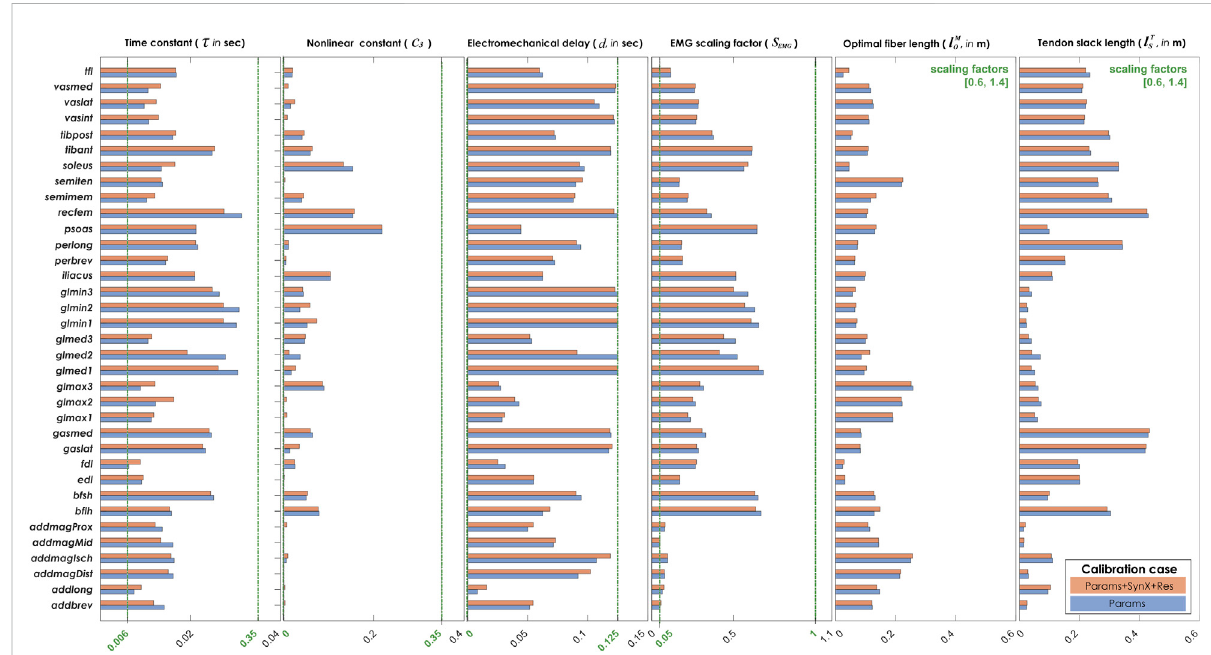
FIGURE 7 Average EMG-driven model parameters of both subjects from “ Params ” calibration (in blue) and “ Params + SynX + Res ” calibration (in orange) Results for “ Params + SynX + Res ” calibration were produced using the best performing methodological combinations for analyzing experimentally measured walking motions (trial-speci fi c unmeasured and speed-speci fi c residual synergy vector weights with six synergies). The upper and lower bounds for each of the four activation dynamics model parameters during optimization have been indicated by green vertical dash-sot lines, where the upper and lower bounds for the scaling factors of optimal fi ber lengths and tendon slack lengths were [0.6, 1.4] for all